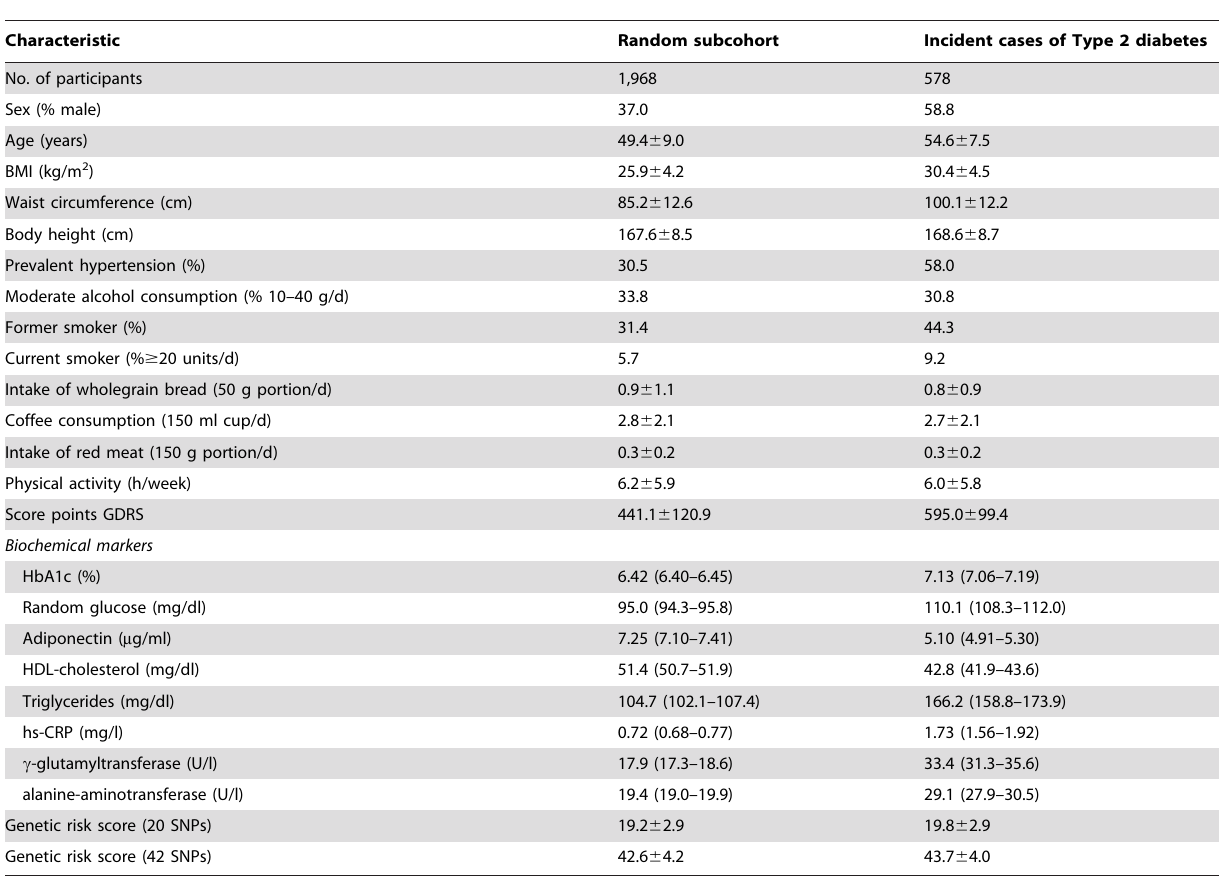
Table 1. Baseline characteristics for the case-cohort of EPIC-Potsdam.